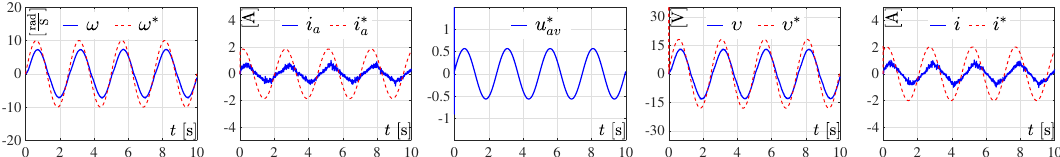
Figure 12. Experimental results for a sinusoidal trajectory. The results related to the measured variables correspond to the signals denoted by ω , i a , υ , i , whereas the results associated with the reference variables are labeled as ω ∗ , i ∗ a , u ∗ av , υ ∗ , i ∗